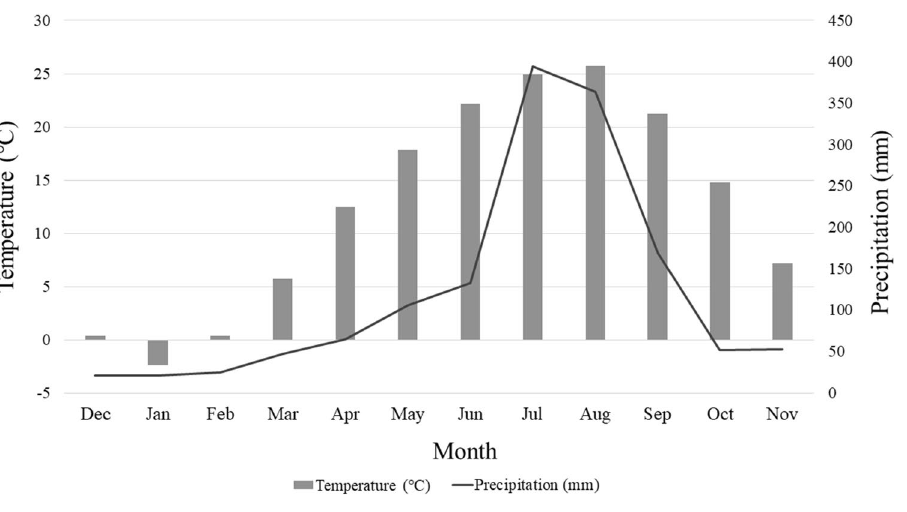
Figure 4. Climate chart of South